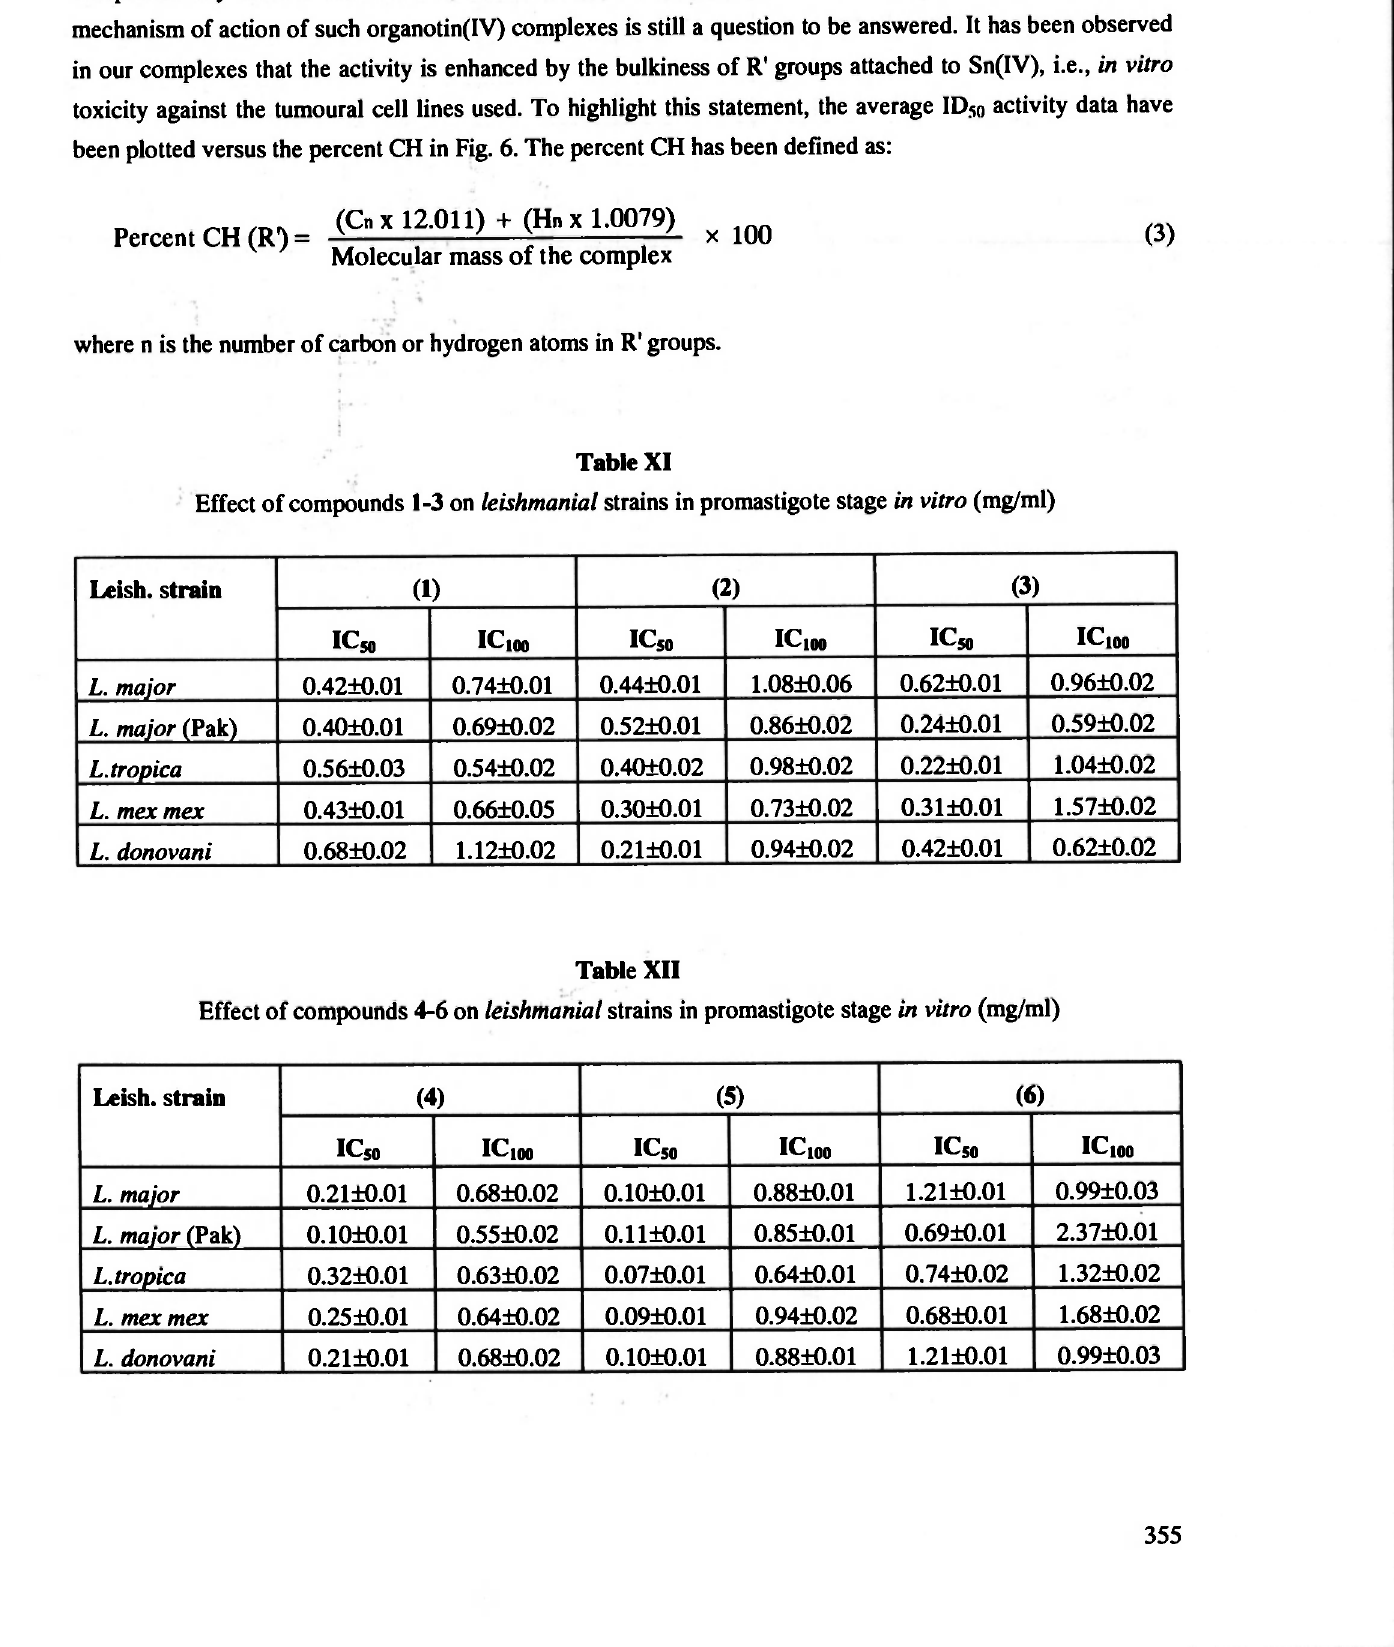
Effect of compounds 4-6 on leishmanial strains in promastigote stage in vitro (mg/ml) Leish.